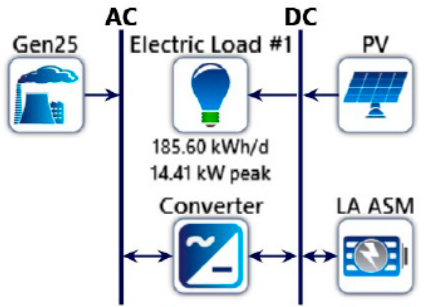
Figure 3. Schematic diagram of the simulated system.